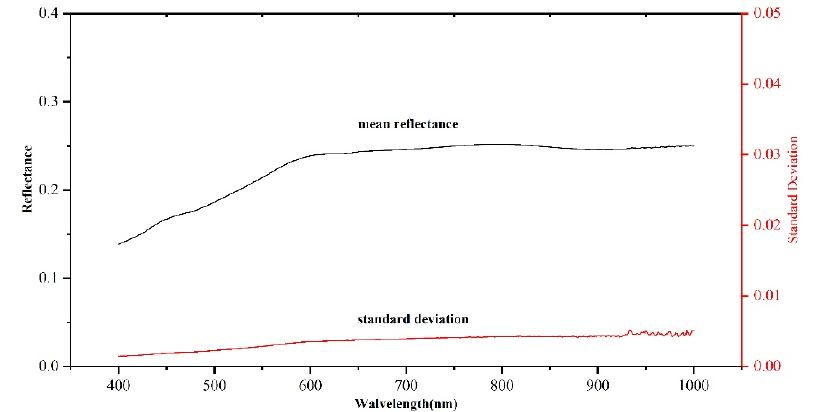
Figure 15. Surface reflectance and standard deviation of Gobi in Dunhuang test site.